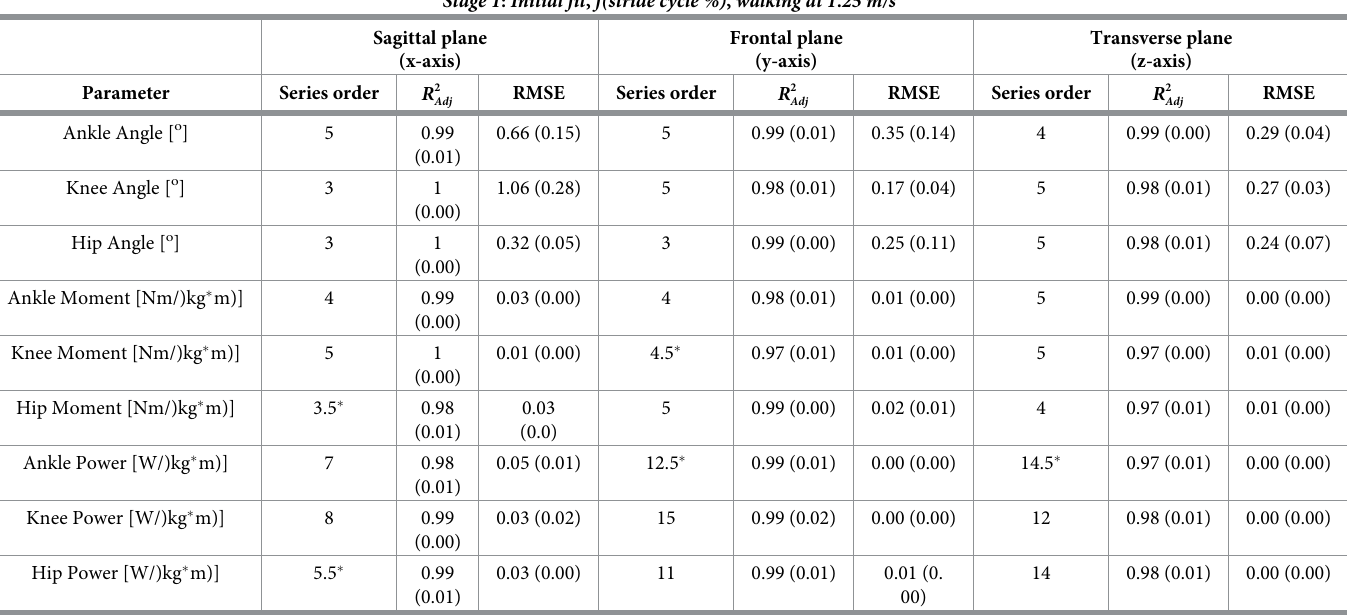
the frontal and transverse planes). S1 File presents an example of how to assemble these equa- tions. Low values of adjusted R 2 are due to failure of the algorithm to fit the data, see S2 File for further explanation and examples. Table 2. Evaluation of the prediction equations for each lower-limb joint variable for each given surface gradient as a function of stride-cycle percentage (Stage 1) in all anatomical planes when walking at 1.25 m/s. The adjusted R 2 and RMSE values are presented as averages across surface gradients (standard deviation (in